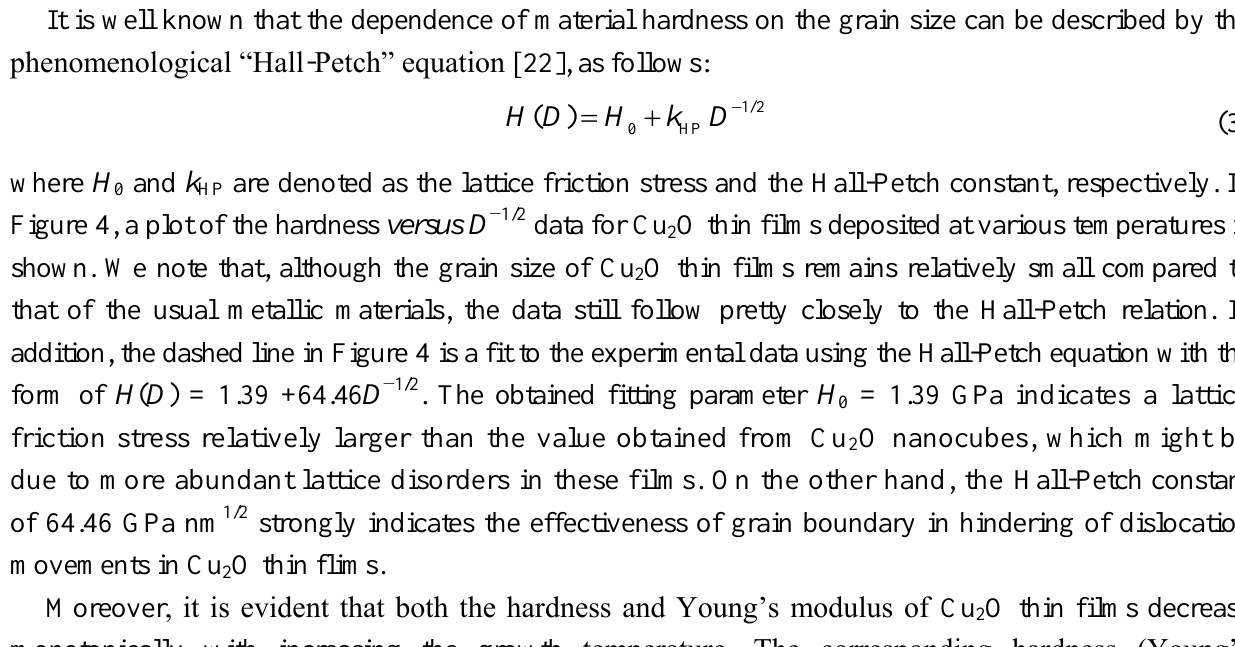
Table 1. Grain size, surface roughness, hardness and Young’s modulus of Cu Growth